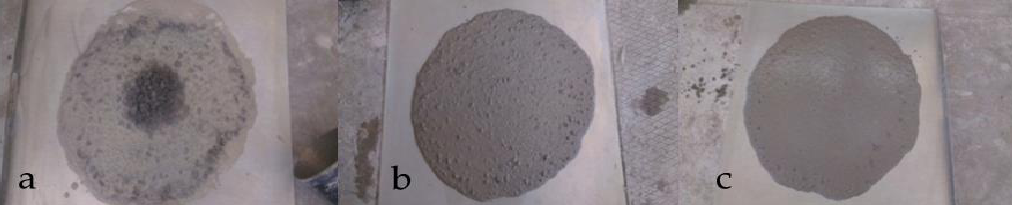
Figure 4. Concrete mixtures prepared with recycled aggregates: ( a ) concrete mixture without AEA and Sf; ( b ) concrete mixture with AEA; and ( c ) concrete mixture with Sf.